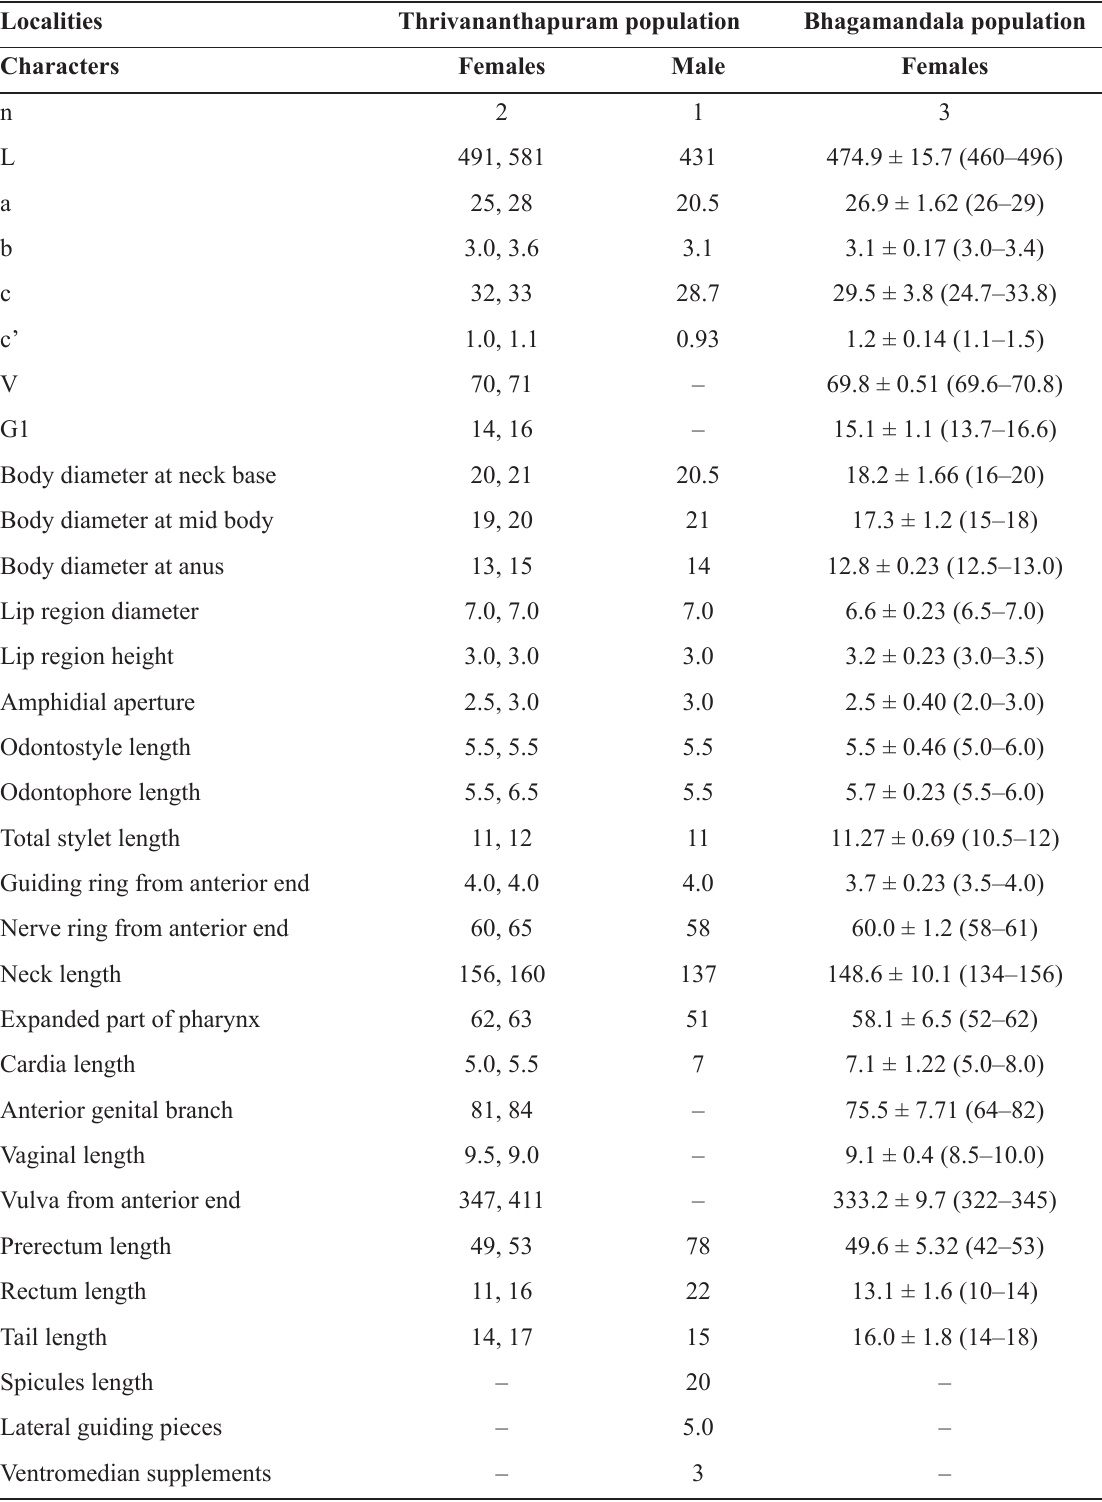
Table 4. Measurements of Tylencholaimus ibericus Peña-Santiago & Coomans, 1994. All measurements are in µm and in the form: mean ± s.d. range) for the Bhagamandala population.